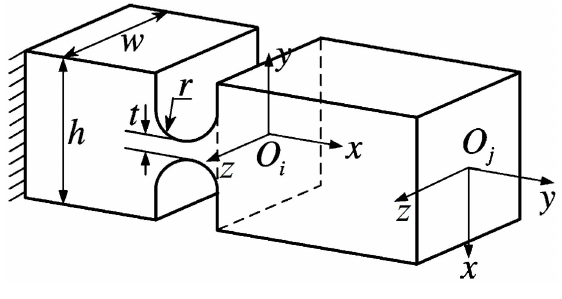
Figure 2. The right circular hinge. Table 1. Parameters of the basic bridge amplifier (mm).